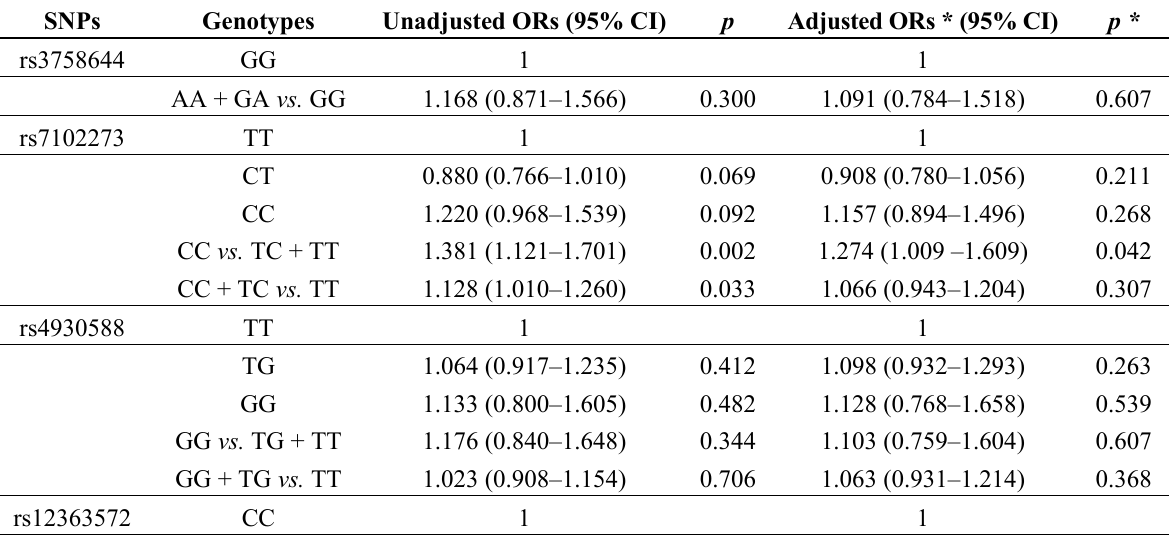
Table 3. Associations of SNPs in LRP5 gene and T2DM in Han